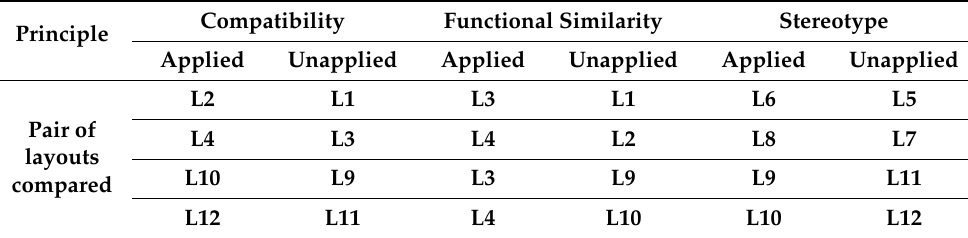
Table 4. Pairs of layouts compared to study the effectiveness of each ergonomic